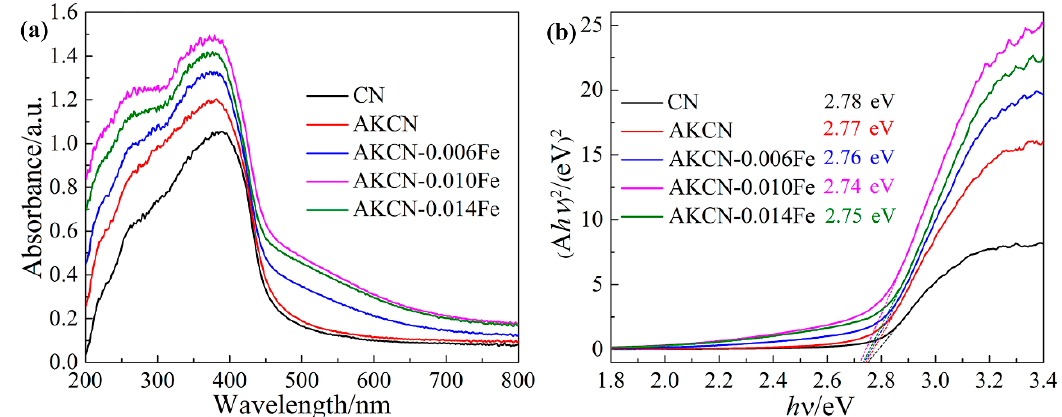
Figure 5. ( a ) UV–visible absorption spectra and ( b ) bandgaps of the synthesized semiconductor